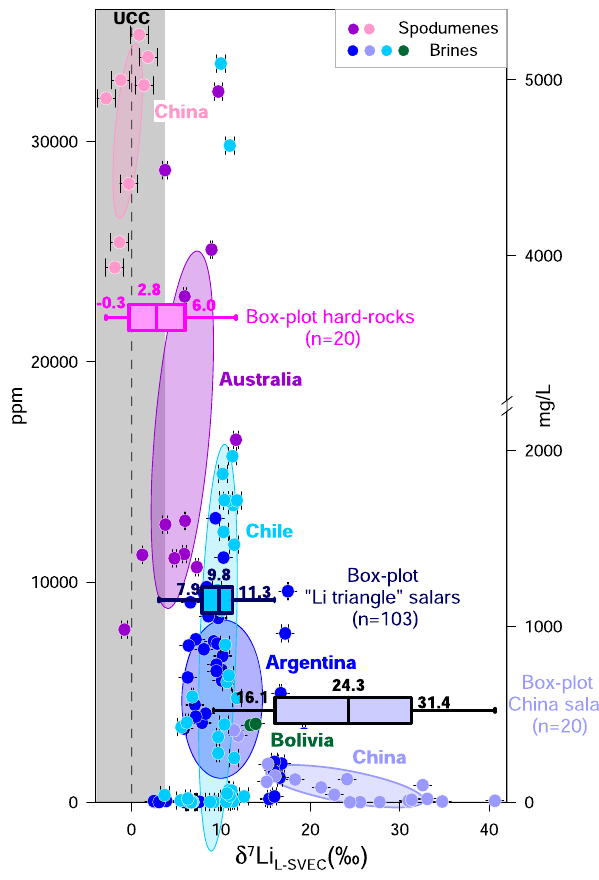
Fig. 2 δ 7 Li value versus lithium content (ppm, mg/L) for various lithium deposits. Spodumenes from West Kunlun (China) and the Yilgarn and Pilbara cratons (Australia) 32 – 34 ; and brines from the Qaidam Basin (China), Salar del Hombre Muerto, Salar de Olaroz, Salar de Pozuelos (Argentina), Salar de Atacama, Salar Grande, Salar de las Parinas, Salar de la Isla, Salar de Pedernales (Chile), and Salar de Uyuni (Bolivia) 35 – 41 . Error bars represent the 2 σ associated with δ 7 Li values. The isotopic compositions of different Li deposits are shown by probability ellipses (con fi dence level p = 0.68). Data are shown with blue box-plots for “ Li triangle ” salars ( n = 103), China salar ( n = 20) and pink box-plots for hard-rocks ( n = 20). The vertical grey line labelled “ UCC ” represents upper continental crust values (UCC): 0 ± 4 ‰ (2 σ ) 31